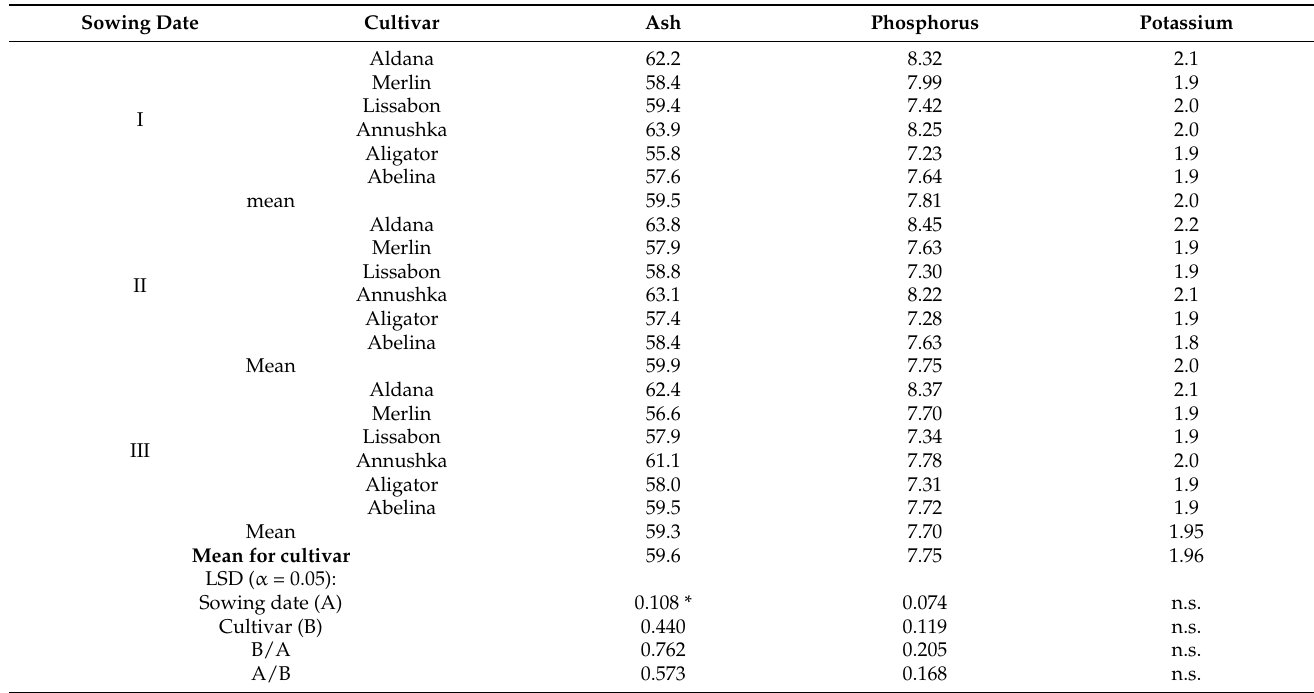
Table 8. Crude ash, phosphorus, and potassium content in soybean seeds depending on cultivar and sowing date (g kg − 1 ).